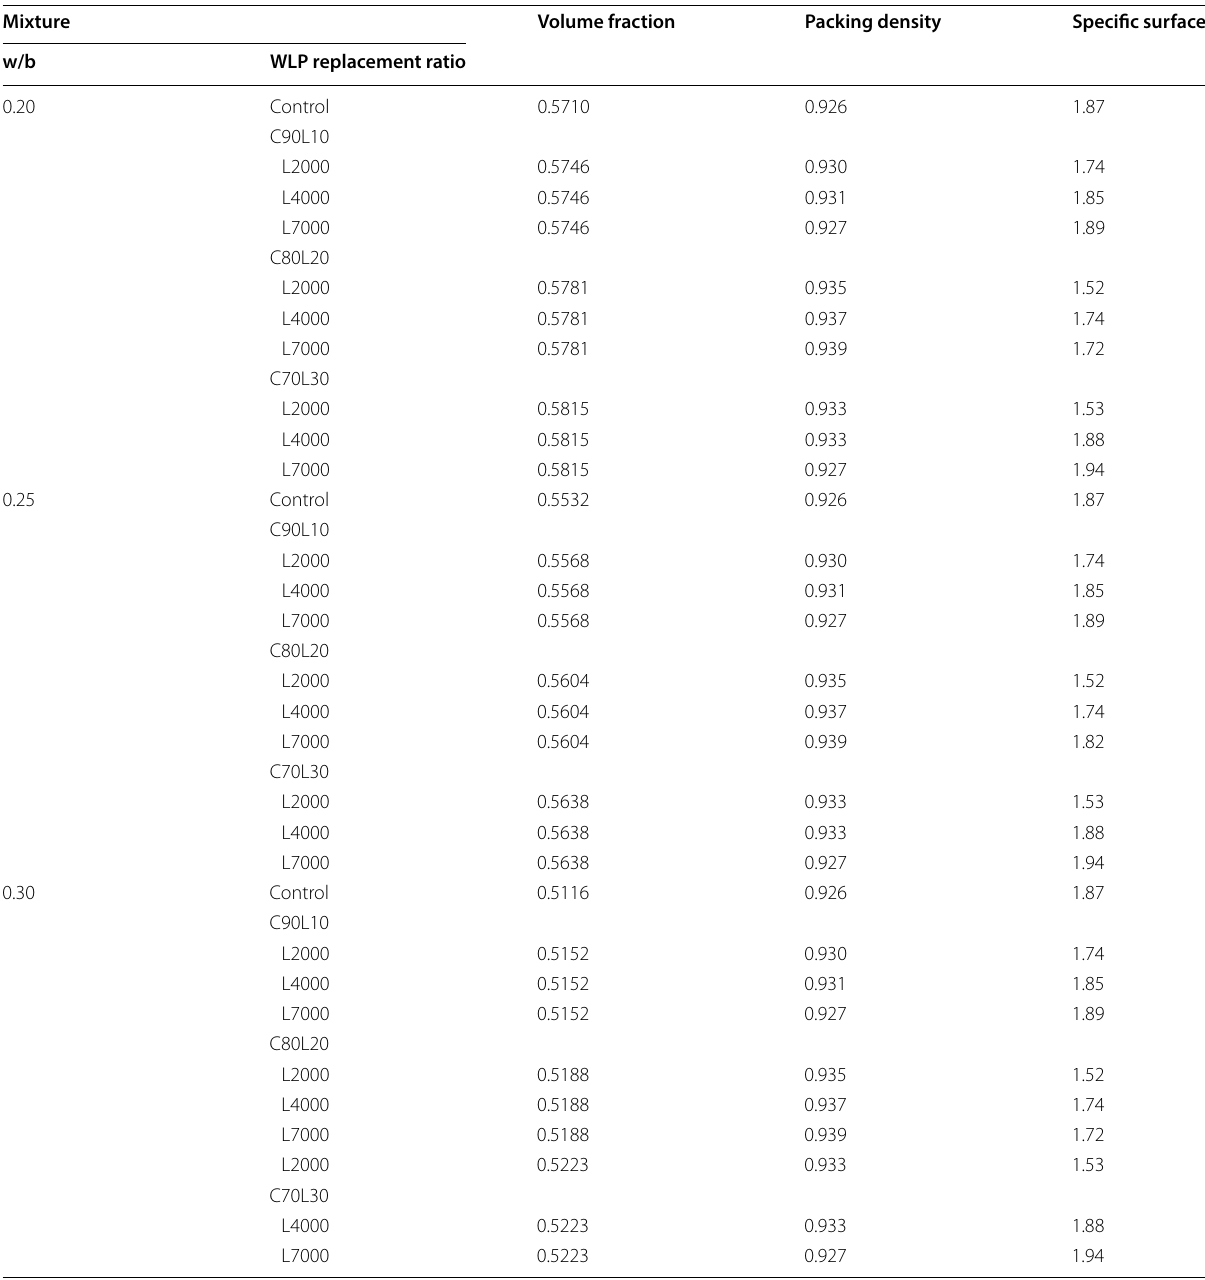
Table 6 Summary of the powder